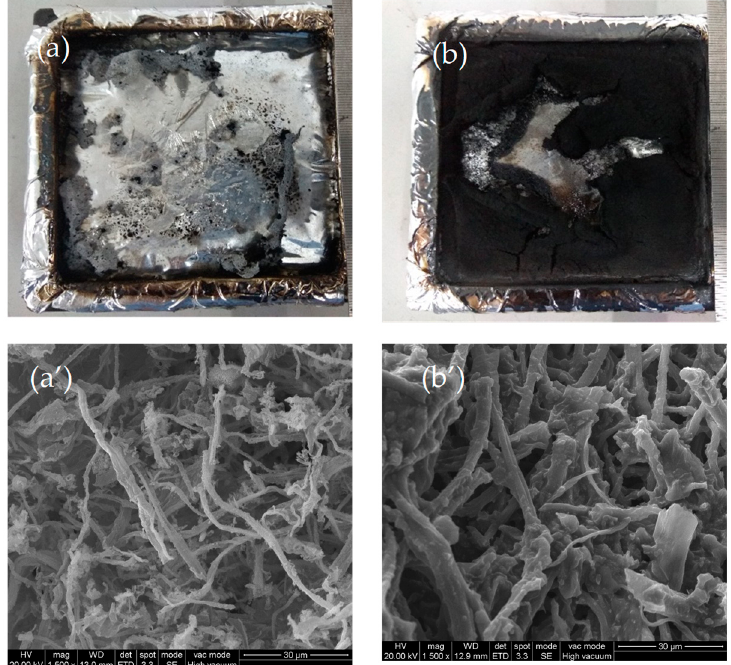
Figure 7. Morphology of char residues of HDPE composites with ( a,a’ ) 7 wt % untreated cellulose, and ( b,b’ ) 7 wt % P,N-doped cellulose after cone calorimeter tests. The top row shows digital photographs, and the bottom row depicts SEM images.